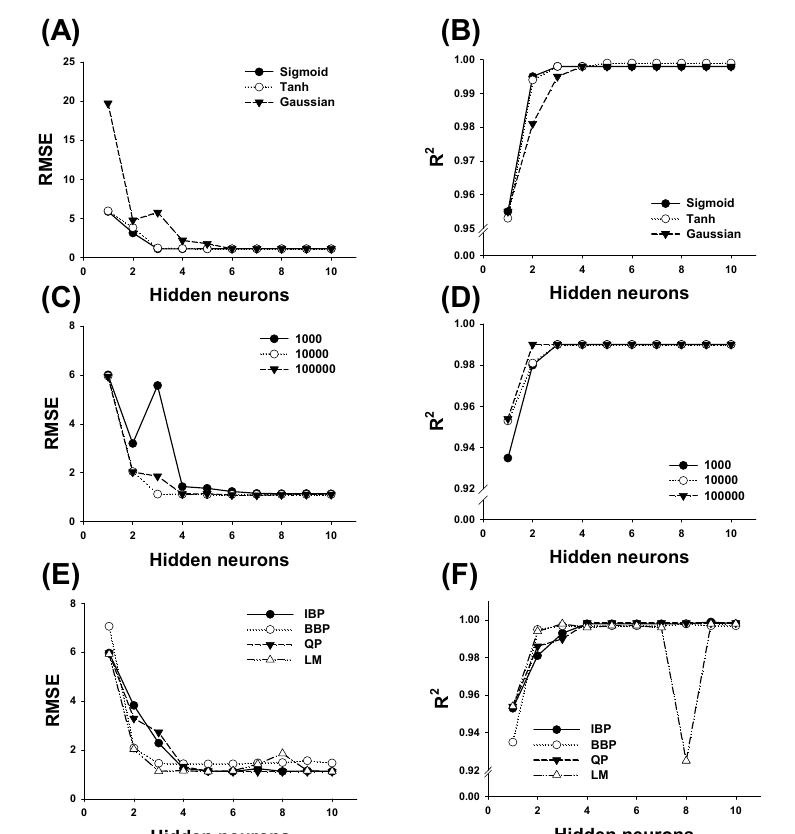
Figure 2. Effects of the transfer function, iteration, learning algorithm and number of hidden neurons on the performance of the artificial neural network (ANN). ( A , B ) Effects of sigmoid, hyperbolic tangent (Tanh), and Gaussian transfer functions employed in the training sets on the performance of ANN. ( C , D ) Effects of iteration (1000–100,000) on the performance of ANN. ( E , F ) Effect of learning algorithm and number of hidden neurons on the performance of ANN. IBP: increment back propagation; BBP: batch back propagation; QP: quick propagation; LM: Levenberg–Marquardt algorithm. ANN performance was evaluated by coefficient of determination ( R 2 ) and root-mean-square error (RMSE).